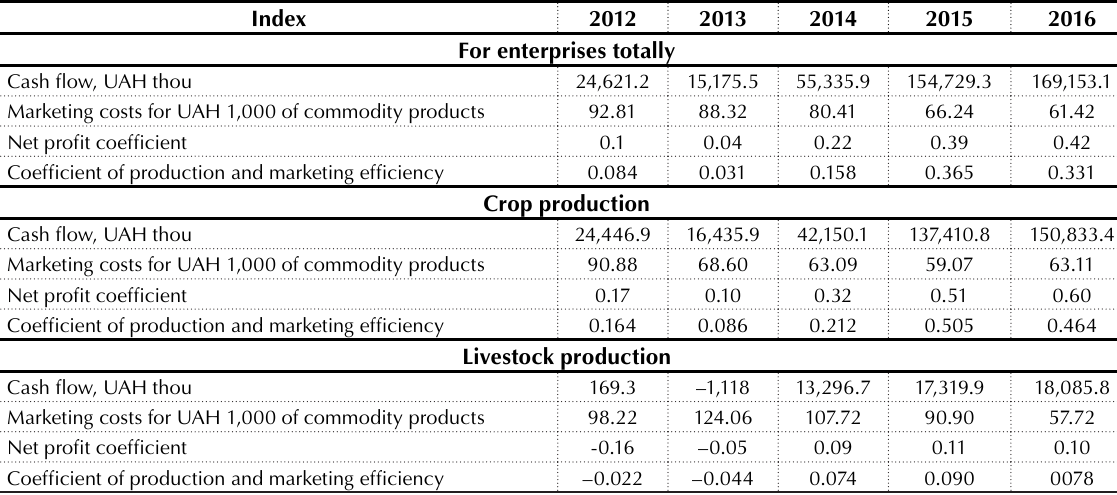
Table 10. Marketing performance of agricultural enterprises in Khrystynivka district, Cherkasy region Source: Calculated according to the data of agricultural enterprises’